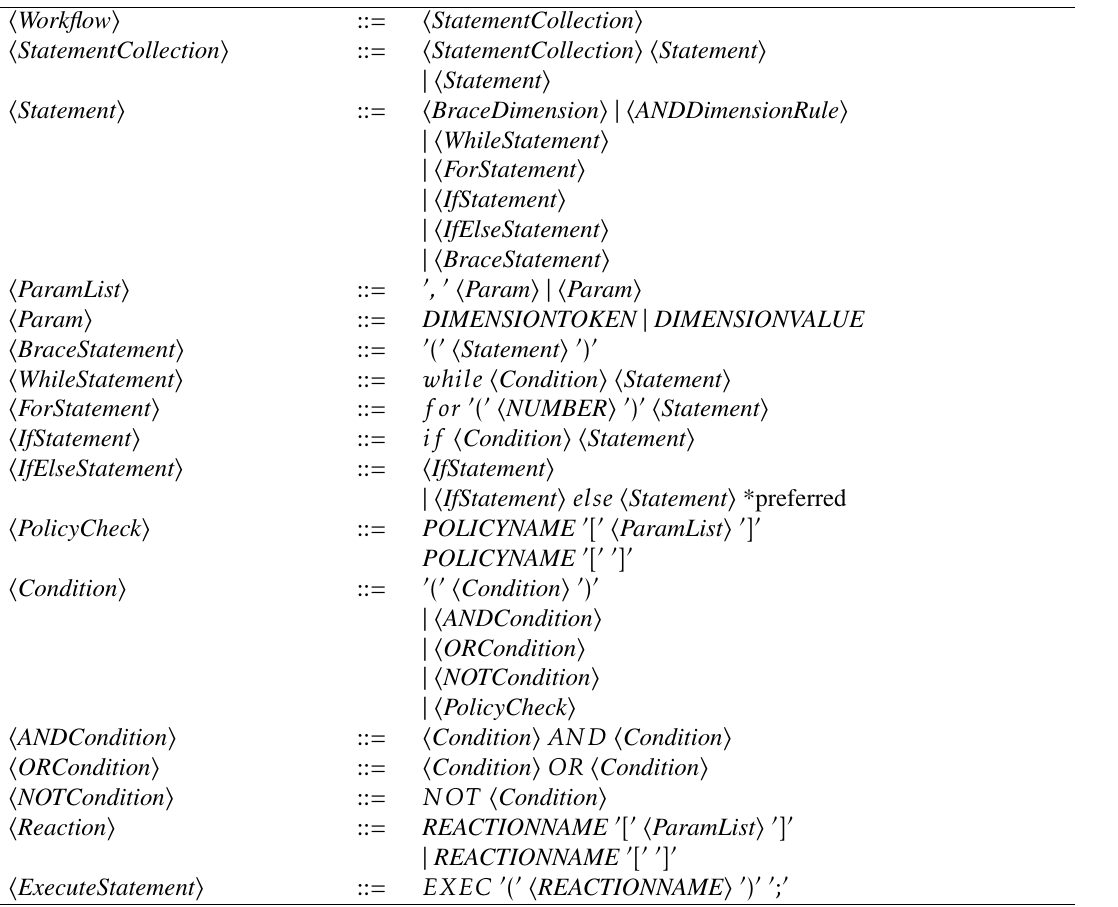
Table 12. Appendix B: Context Free Grammar for Adaptations in